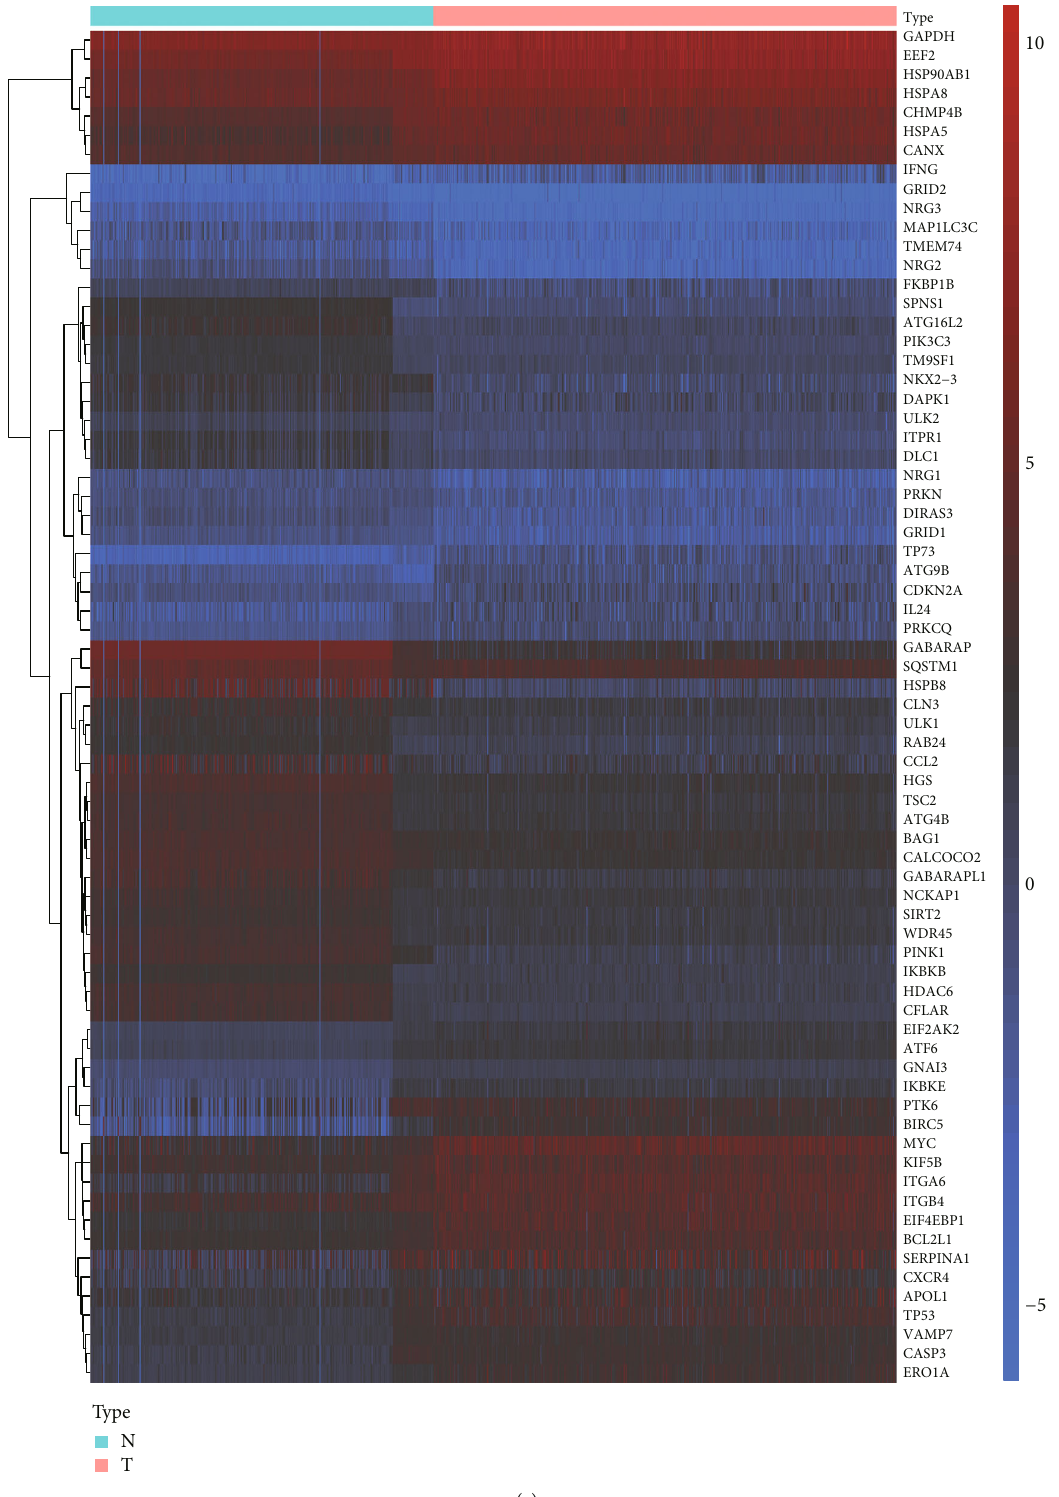
Figure 1: Identi fi cation of hub autophagy signature in breast cancer. (a) Volcano plot was drawn to show the di ff erentially expressed genes in CRC versus normal samples. (b, c) The DEG expression in CRC versus normal samples was illustrated by box and heat map plots,